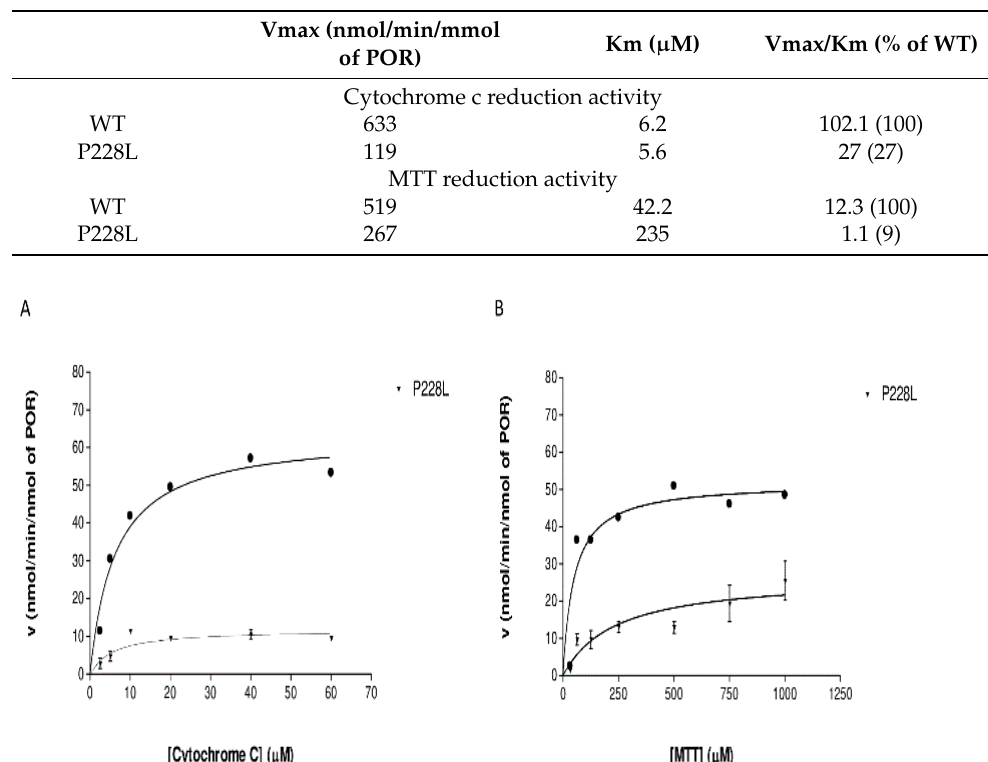
Figure 6. Reduction kinetics of model electron acceptors by WT (black dot)and P228L (inverted triangle) POR. ( A ) Cytochrome c reduction assays by WT and P228L POR. ( B ) MTT Reduction assay with WT and L374H variant of POR. The curves represent the best nonlinear fits to the Michaelis– Menten equation.